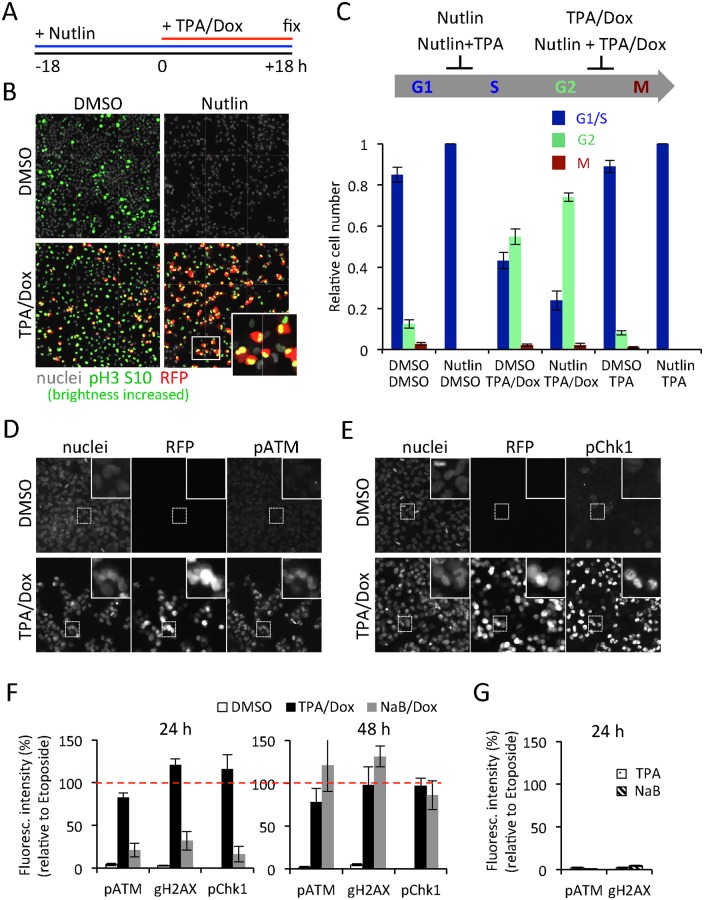
During lytic reactivation iSLK.219 cells 'by-pass' the G1-checkpoint and accumulate high levels of DNA damage.(A) Schematic representation of the Nutlin pretreatment experiment. iSLK.219 cells were treated with Nutlin 18h before reactivation with TPA/Dox. Cells were fixed 18h later and processed for immunofluorescence and high-content imaging. (B) Fluorescence images of iSLK.219 cells treated as in (A) and processed for immunofluorescence using antibodies against pH3 S10 (green). Lytic reactivation was monitored by RFP (red) expression, nuclei were stained with Hoechst. (C) Quantification of cell cycle progression by image analysis from the experiment shown in (B). In each condition, the values are normalized to the total number of cells (set as one). The cell cycle arrest induced by the different treatments is summarized in the scheme above the chart. (D-E) Representative fluorescence images of iSLK.219 cells reactivated with TPA/Dox for 24 h and processed for immunofluorescence staining of two markers of DNA damage response, phosphorylated ATM (pATM, D) and phosphorylated Chk1 (pChk1, E). The insets show higher magnifications of cells from the respective white-boxed areas. Nuclei are stained with Hoechst and virus reactivation monitored by RFP expression. (F) Quantification of the median fluorescence intensity of indicated markers of DNA damage in cells treated as indicated for 24 h or 48 h and processed for immunofluorescence analysis. For each marker, values were normalized to the median fluorescence intensities obtained from iSLK.219 cells treated with Etoposide (6.25 μM) for the same times (100%, red-dashed line). Error bars represent the SD of three independent experiments. (G) The fluorescence intensity of indicated DNA damage response was quantified as in (F) in cells treated with TPA or NaB for 24 h.